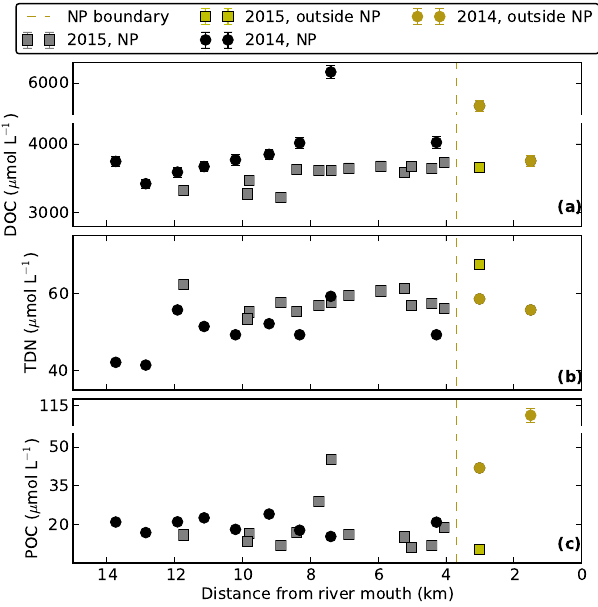
Figure 2. DOC, TDN and POC as measured along the river stretch. Flow direction is from left to right. Note the discontinuous vertical axis in (a) and (c) . The yellow markers to the right of the dashed line refer to sampling stations outside the national park. The legend applies to all